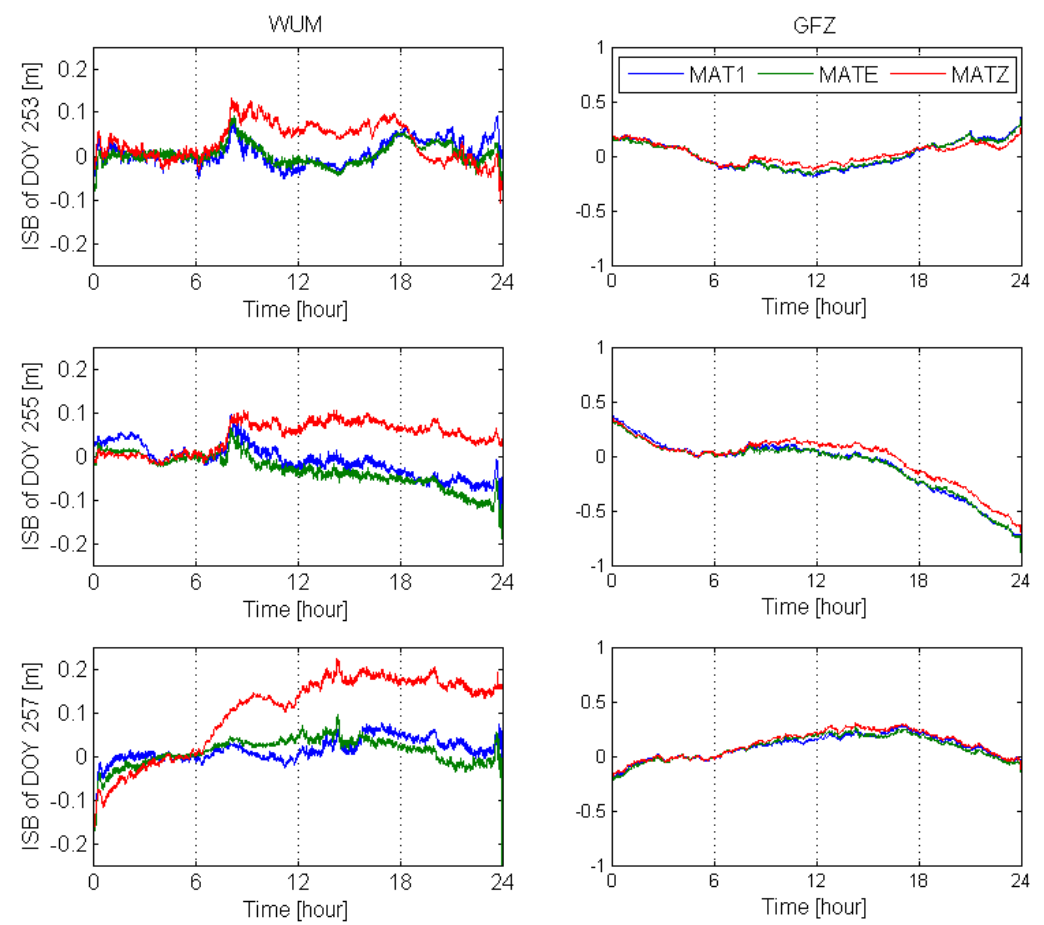
Figure 4. GPS / BDS ISB series of MAT1 / MATE and MATZ estimated using WHU, CODE and GFZ Figure 4. GPS/BDS ISB series of MAT1/MATE and MATZ estimated using WHU, CODE and GFZ precise products on DOY 253, 255, 257, 2018. precise products on DOY 253, 255, 257, 2018.